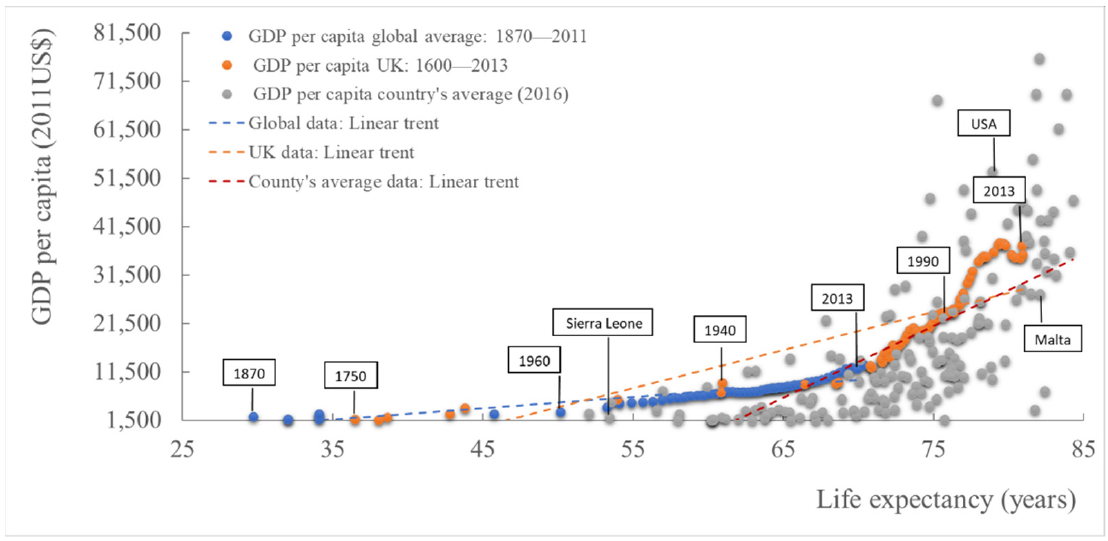
Figure 1. Life expectancy related to GDP per capita per year [6]; global average (1870–2011) and 172 countries’ average data (2016) [7] and UK data (1600–2013) [8].